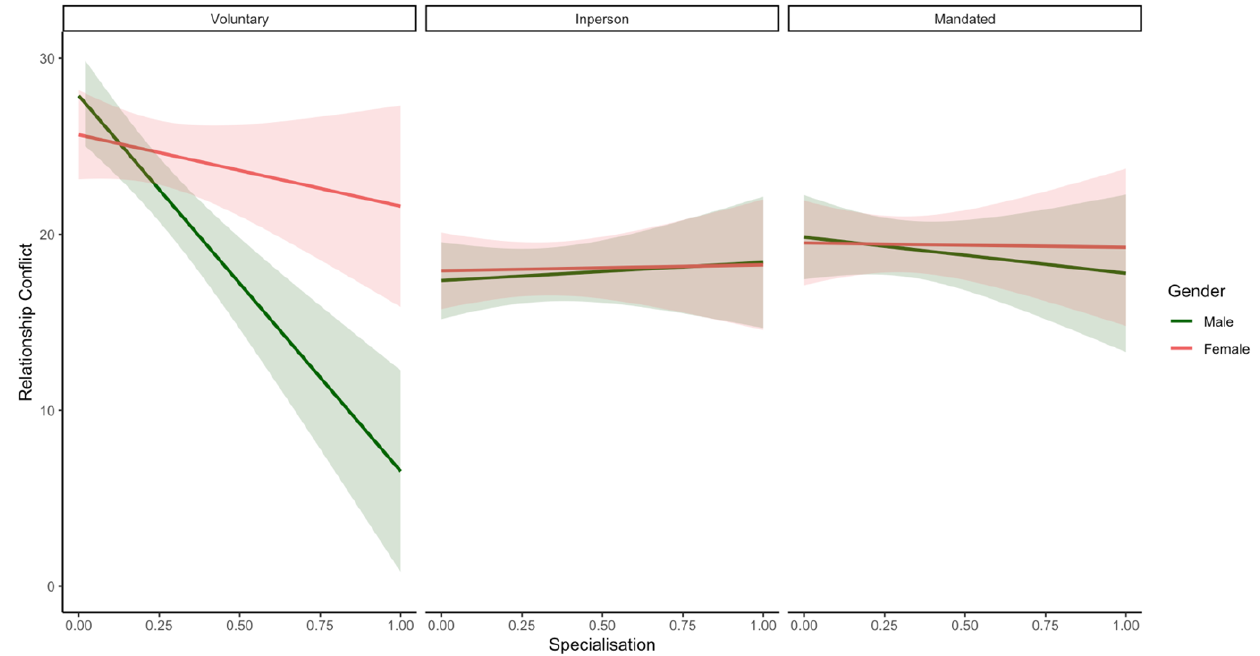
Figure 5. Simple slopes analyses demonstrating the three-way interaction between specialisation, gender, and scho oling status on parents’ relationship conflict in mixed -gender couples. There was also a significant three-way interaction between equity, parent gender, and homeschooling status with regard to parent depression (only marginally) and rela- tionship conflict (Table 10; see Figures 6 and 7), but not any other outcomes. Simple slopes analyses indicated that female parents of in-person learners ( β = −3 .25.; p = 0.01) had mar- ginally significant negative associations between equity and depression (see Figure 6); this association was not significant in male and female mandated homeschoolers ( β = −2 .24.; p = 0.13; β = −2 .80, p = 0.06) as well as male parents of in-person learners ( β = 0.34; p = 0.79). Equity and depression were not significantly associated in male or female voluntary homeschoolers ( β = 0.01, p = 1.00; β = 0.63, p = 0.74). With regard to relationship conflict, male and female voluntary homeschoolers reported opposing effects of equity ( β = 3.80, p = 0.42; β = −8 .99, p = 0.06), although these relations were not significant. Further, there was a marginally significant negative association between equity and relationship conflict in male parents of in-person learners ( β = −6 .52, p = 0.04); this was similar but not significant in their female counterparts ( β = −5 .76, p = 0.07). Lastly, equity and relationship conflict were not significantly associated in mandated homeschoolers (both male and female par- ents; all p -values > 0.05). Table 10. Effects of equity and homeschooling status on male vs. female parents’ well -being in mixed-sex couples. Outcome